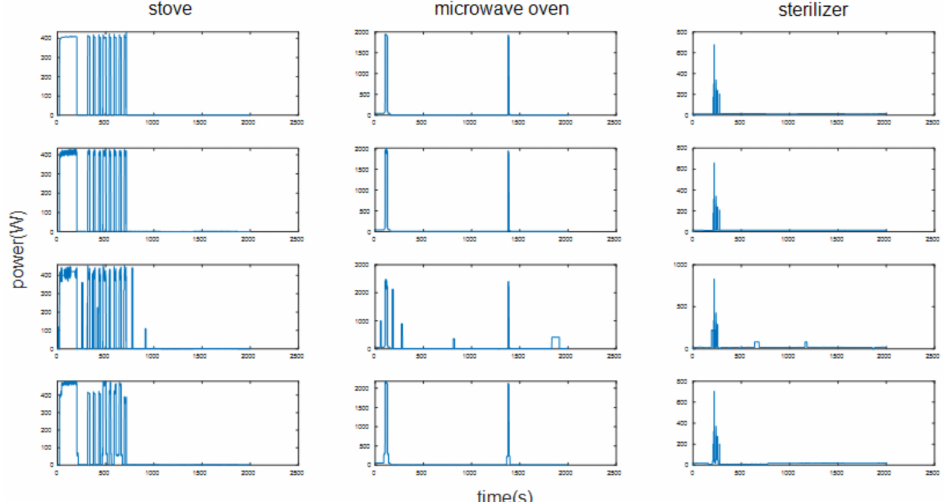
Figure 7. Identification result of Household 2 after using the network trained by dataset of House- hold 1 (Line 1: the actual power curve of the load; Line 2: the load identification result based on the improved dAE algorithm; Line 3: the load identification result based on the standard dAE algorithm; Line 4: the load identification result based on the FHMM